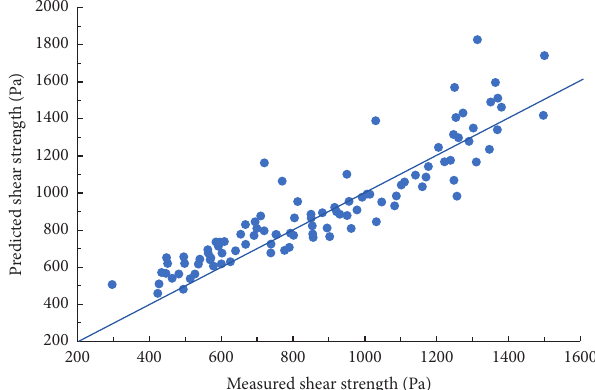
Figure 3: Comparison between the measured and predicted values. Table 6: Data for validating the prediction